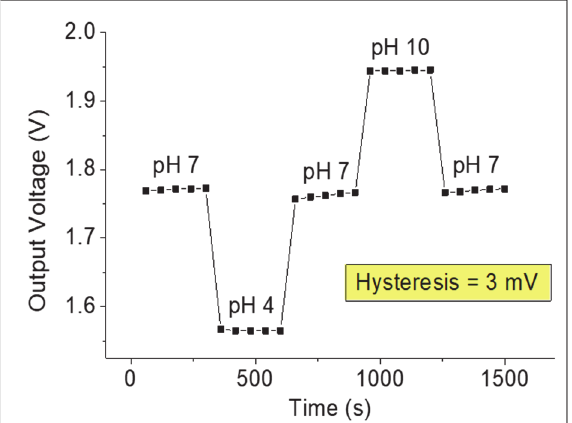
Figure 6. Output voltage of nitrate sensor and logarithmic nitrate concentration in the range of 10 to 30 ppm for ( a ) TiO 2 thin film, ( b ) TiO 2 –PANI bilayer composite thin film, ( c ) TiO 2 –PANI composite thin film, and ( d ) ITO substrate.